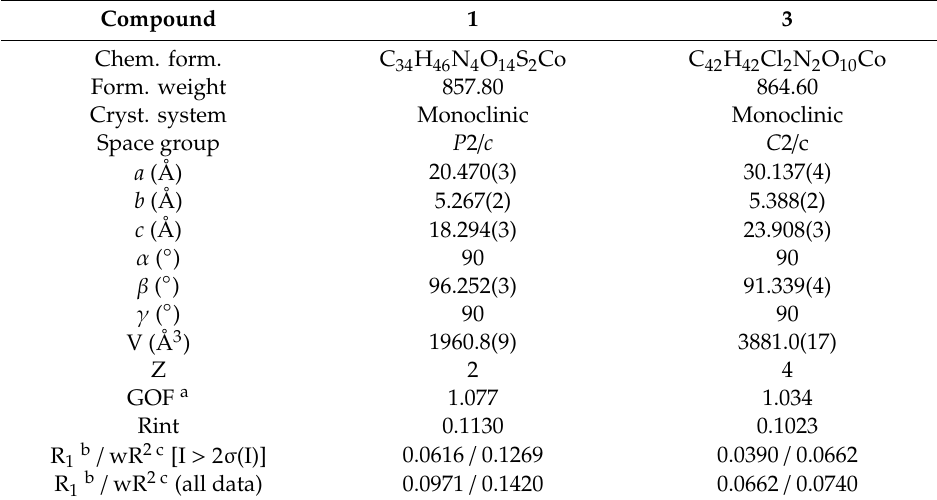
Table 3. Crystallographic data and structure refinement details of all